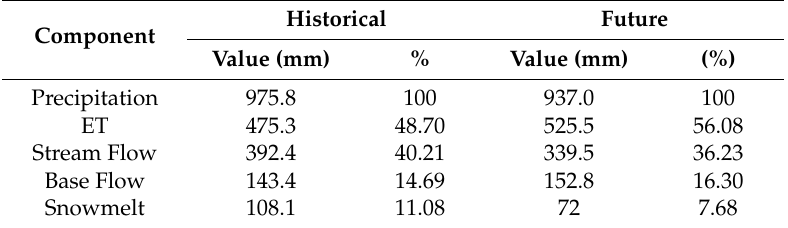
Table 4. Water Balance Components for Historical (1985–2014) and Future (2015–2044) Periods.